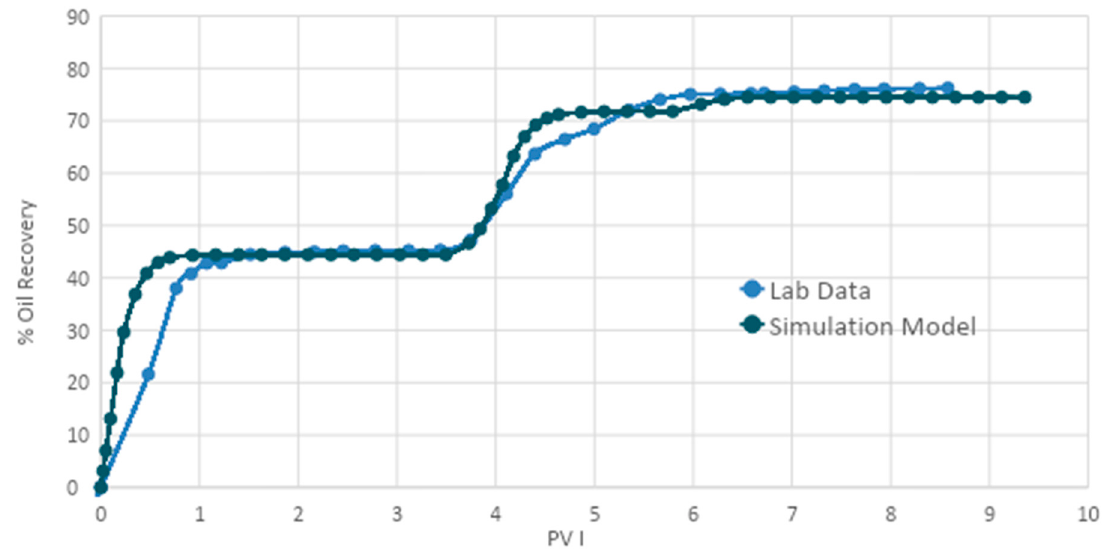
Figure 15. Simulated and laboratory oil recoveries.